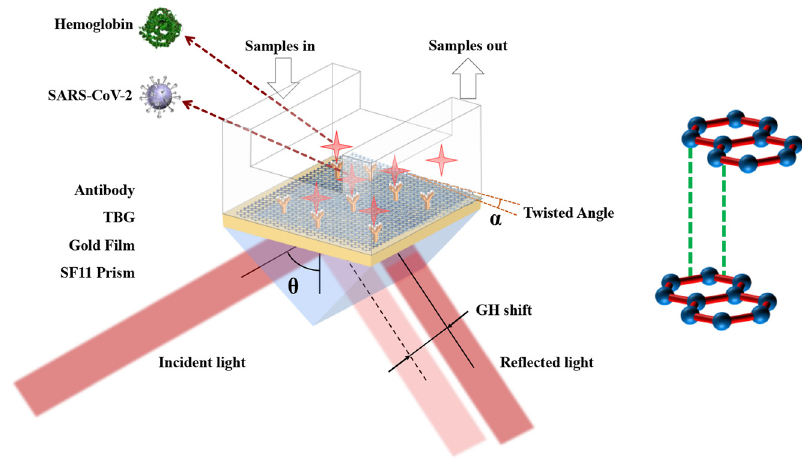
Figure 1: Schematic diagram of TBG-enhanced SPR